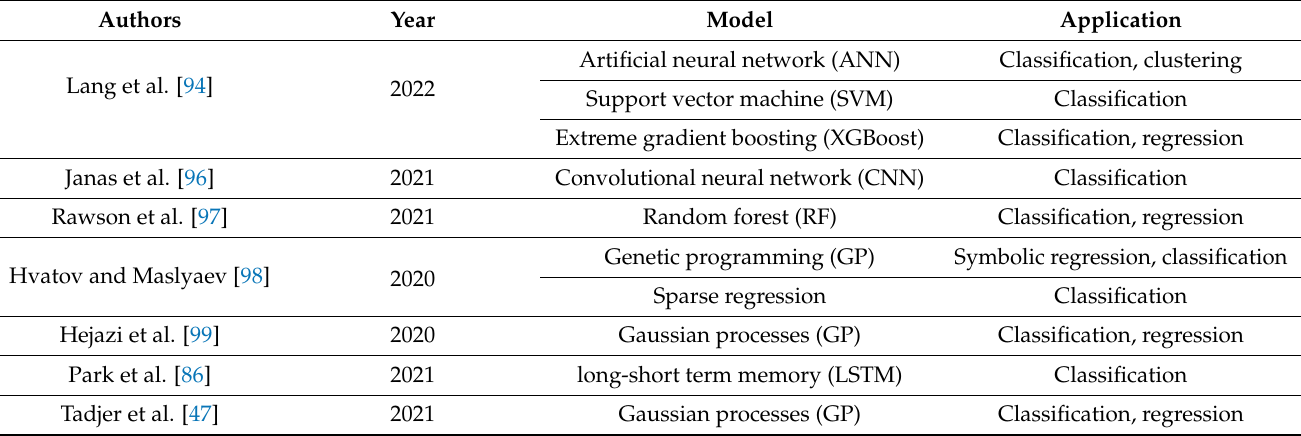
Table 2. List of some selected AI models that could fit the Metocean data